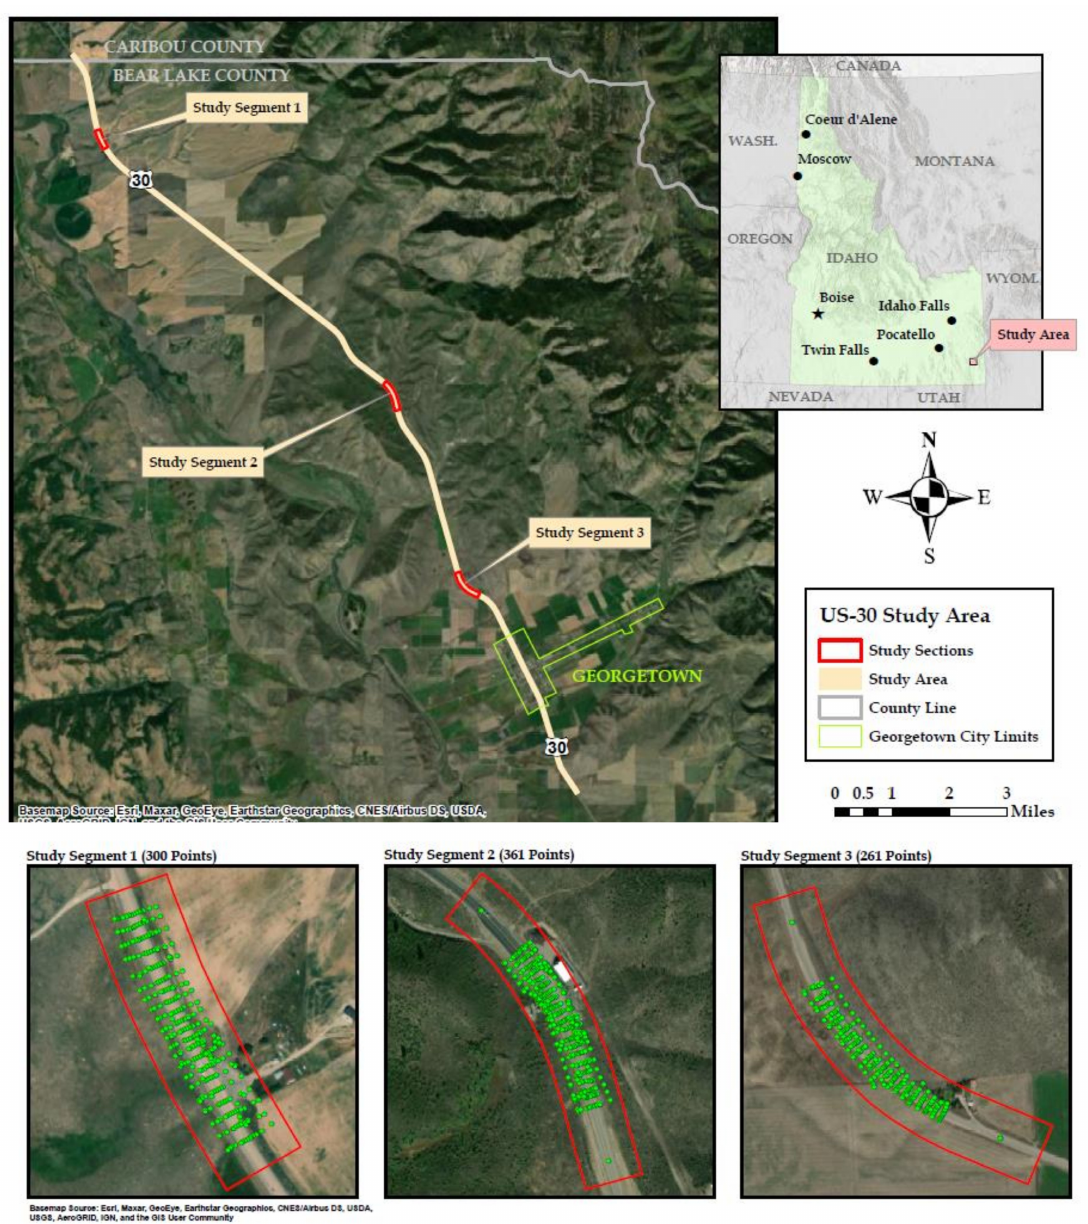
Figure 1. Google Earth image of the study